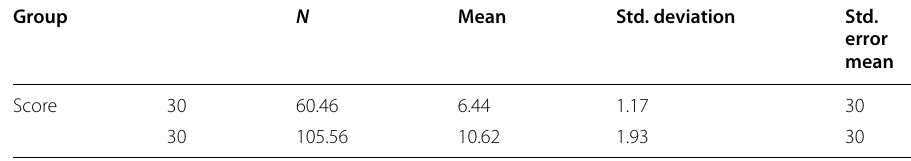
Table 23 Self‑efficacy post‑test descriptive statistics Group N Mean Std. deviation